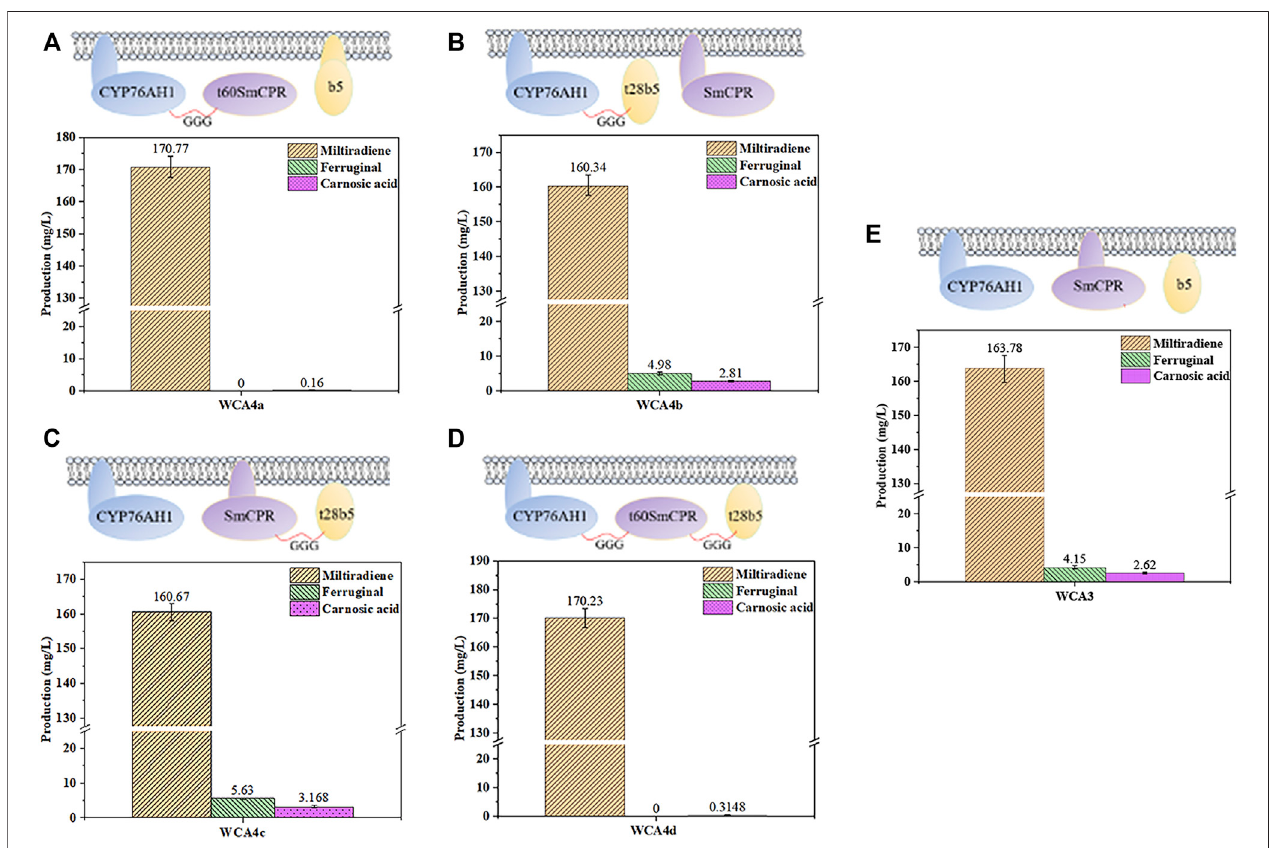
FIGURE 5 | In fl uence of different fusion strategies on miltiradiene, ferruginol and CA production. (A) WCA4a: CYP76AH1 ~ t60SmCPR, SpCytb5; (B) WCA4b: SmCPR, CYP76AH1 ~ t28SpCytb5; (C) WCA4c: SmCPR ~ t28SpCytb5, CYP76AH1; (D) WCA4d: CYP76AH1 ~ t60SmCPR ~ t28SpCytb5. (E) WCA3: CYP76AH1, SmCPR and SpCytb5 in the natural state. The data are the averages of three separate experiments.